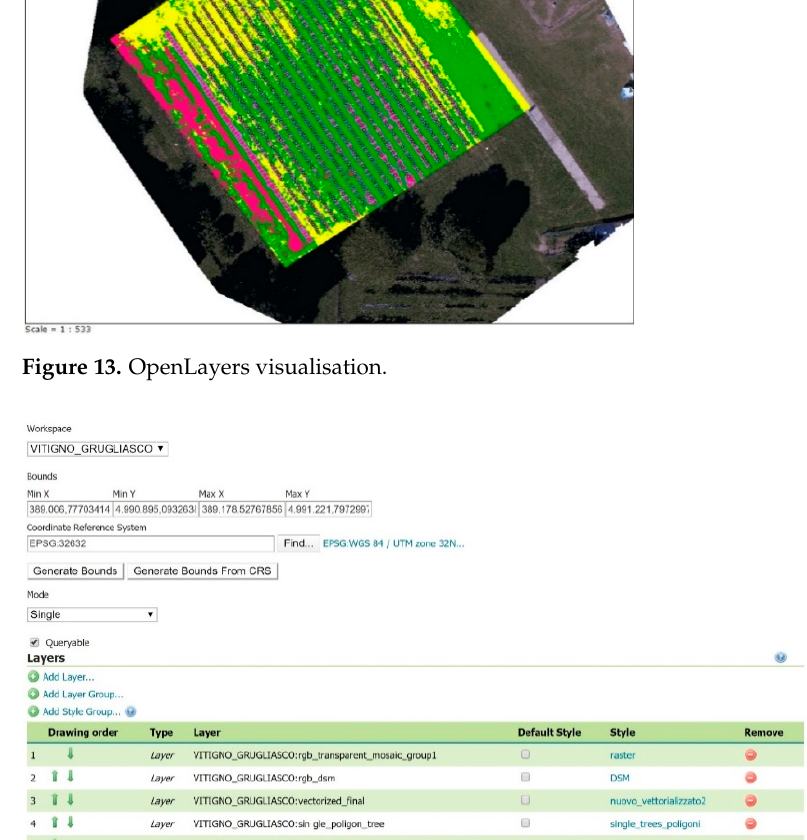
Figure 14. Workspace creation for the Grugliasco vineyard Figure 13. Workspace creation for the Grugliasco vineyard WebGIS.